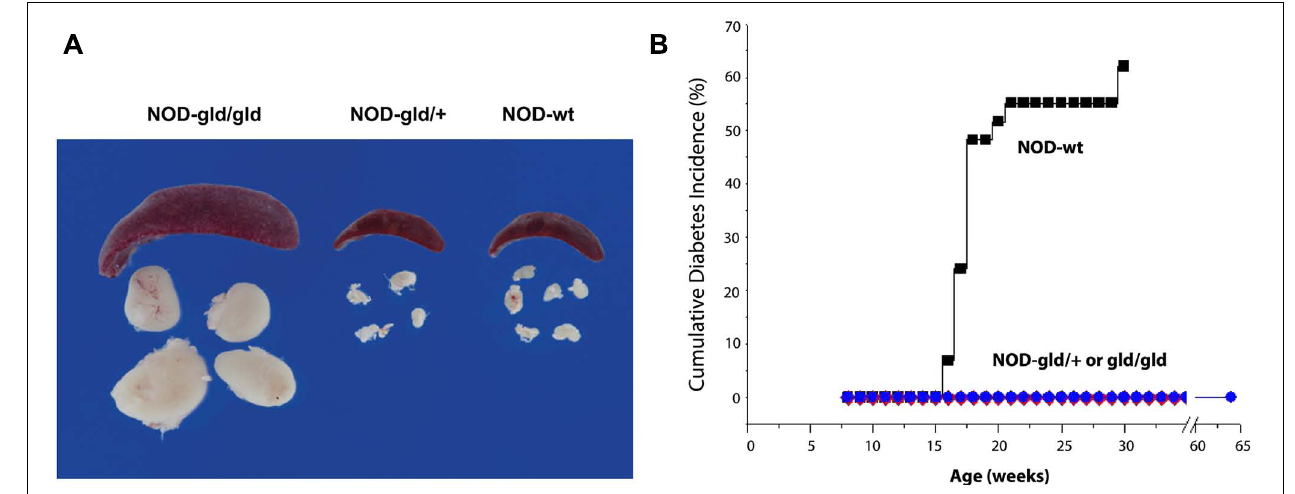
mutations develop an age-dependent lymphoproliferation (A) and become completely protected from diabetes (B) . NOD mice bearing the heterozygous gld mutation develop no lymphoproliferation but become completely protected from autoimmune diabetes (B) .Wild type NOD mice develop